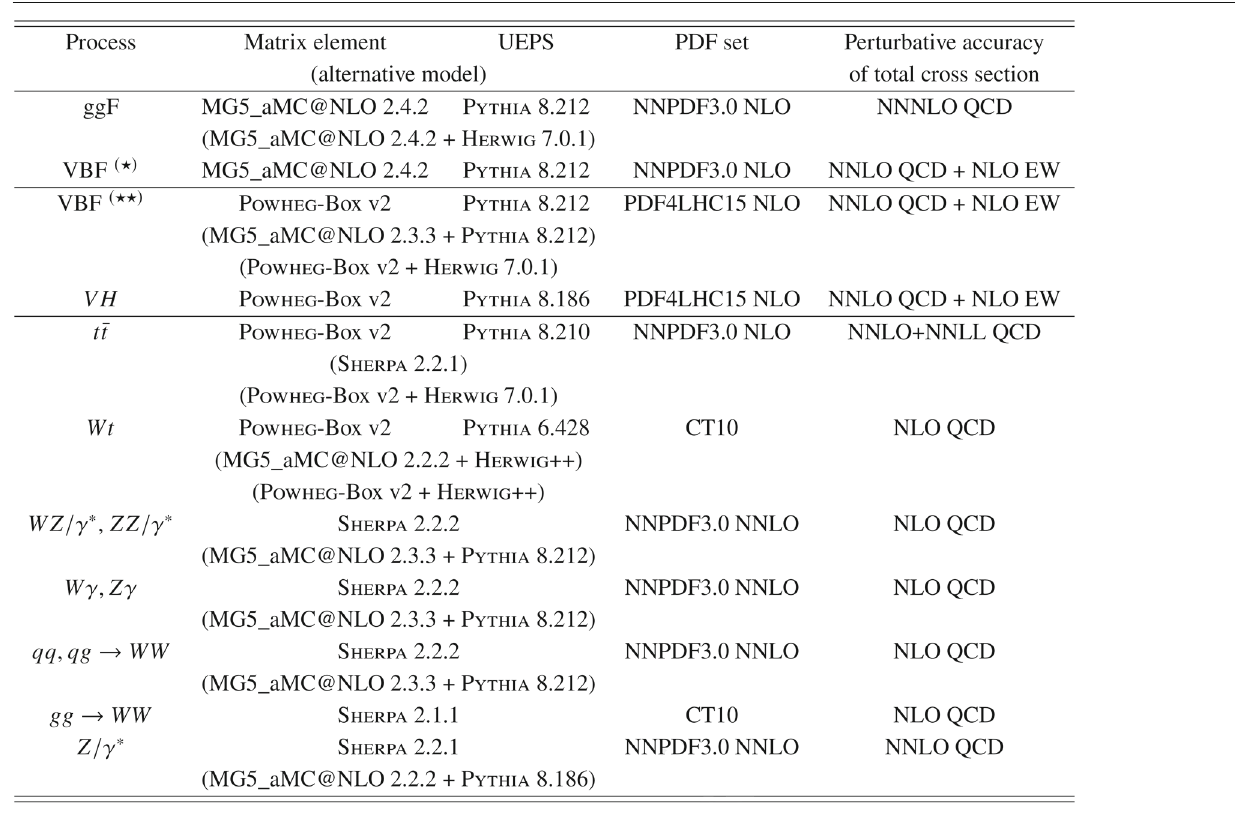
Table 2 Overview of the simulation tools used to generate signal and background processes, and to model the underlying event and parton shower. The PDF sets are also summarised. The perturbative accuracy (in QCD and if relevant in EW corrections) of the total cross section is stated for each process. The configuration marked with ((cid:2)) is used for the signal samples in the studies of the Higgs boson couplings to longitudinally and transversely polarised W and Z bosons, while the